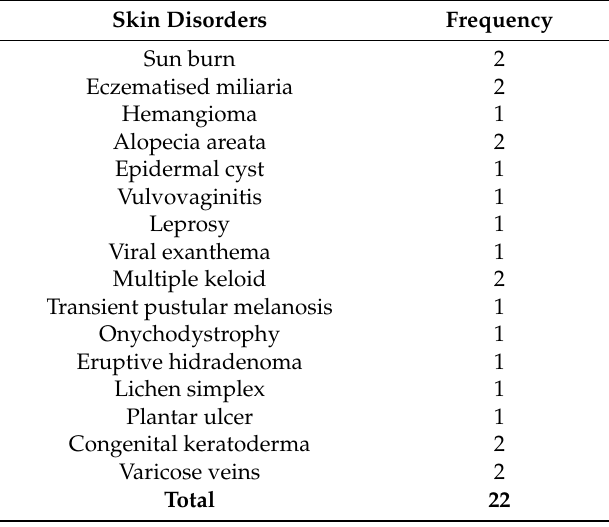
Table 3. Miscellaneous skin conditions diagnosed via the platform in 22 cases out of 180 cases posted from health